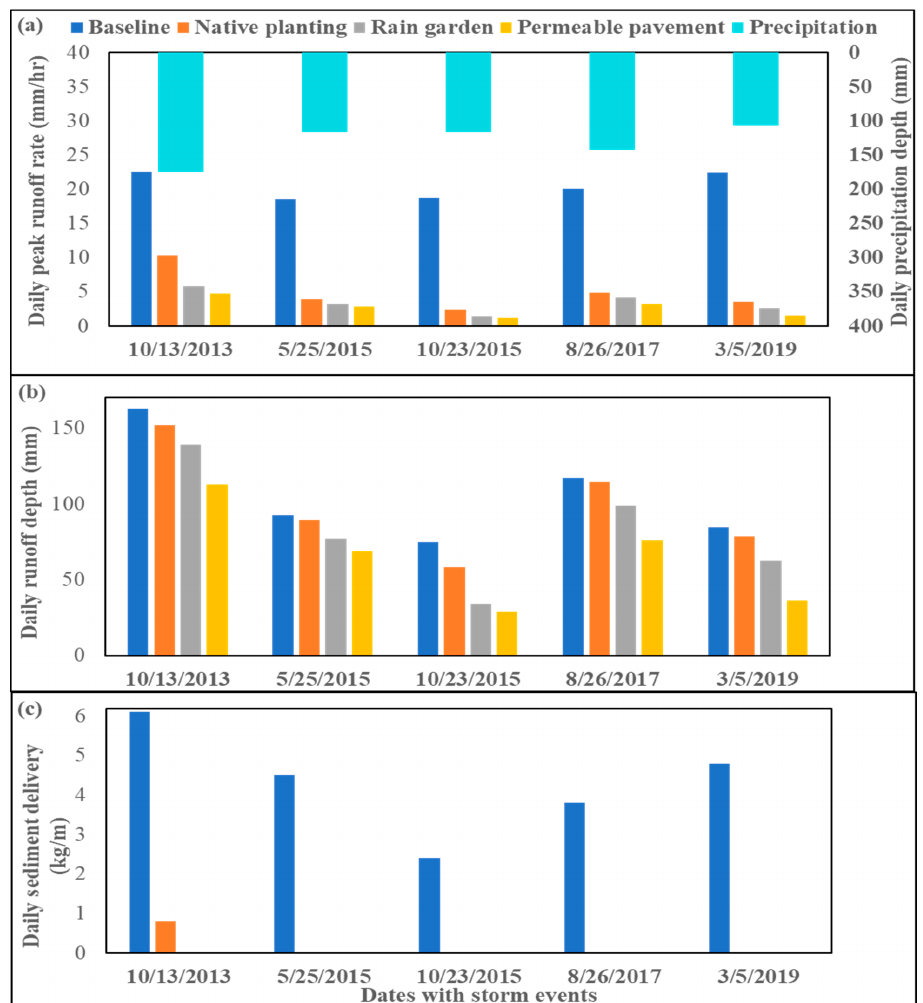
Figure 7. Daily peak runoff rate ( a ), runoff depth ( b ), and sediment delivery ( c ) for baseline, native planting, rain garden, and permeable pavement for a single hillslope (hillslope 16).